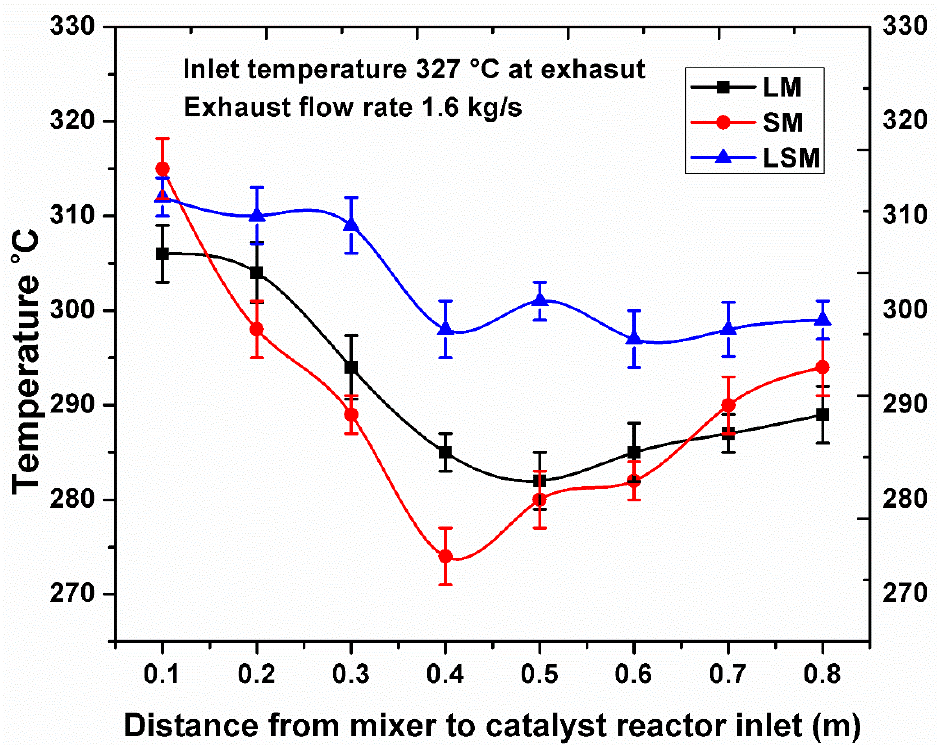
Figure 13. Axial distribution of temperature from mixer downstream to catalyst inlet in pipe wall.